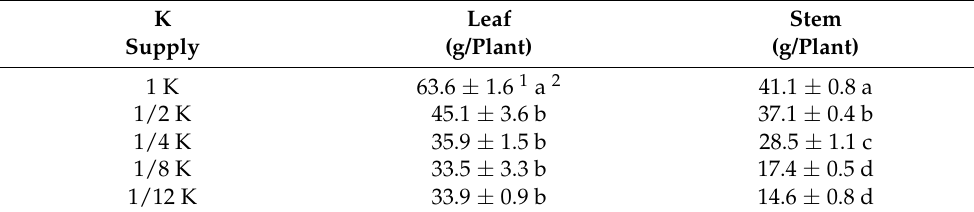
Table 2. Leaf and stem dry weight of hydroponically grown cherry-type tomato plants at the end of the experiment under five quantitative K-supply regimes. K